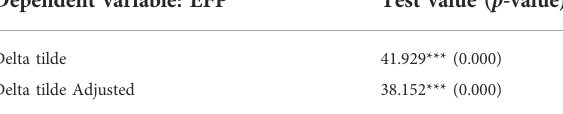
TABLE 4 Results of Slope heterogeneity analysis.